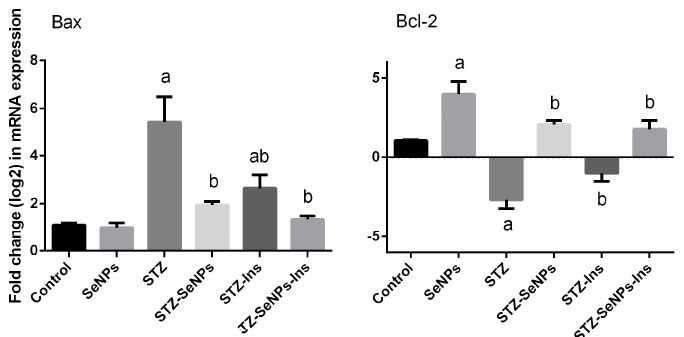
Figure 6. Impact of SeNPs and/or insulin on the expression of apoptosis genes in the testis in control and STZ-diabetic rats. Results (mean ± SEM of triplicate) were arrived according to the mRNA level of β -actin RNA and are shown as fold induction (in log2 scale) of the mRNA level in the control.